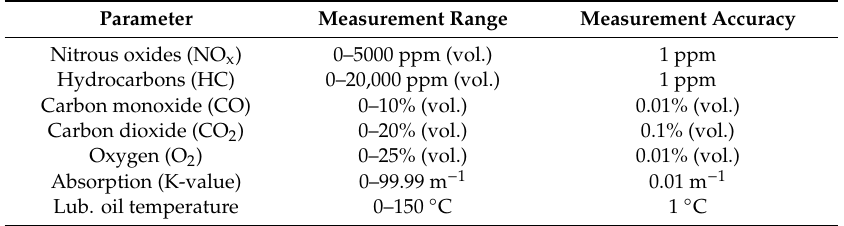
Table 3. Measurement range and resolution of HORIBA PG-250 analyser.